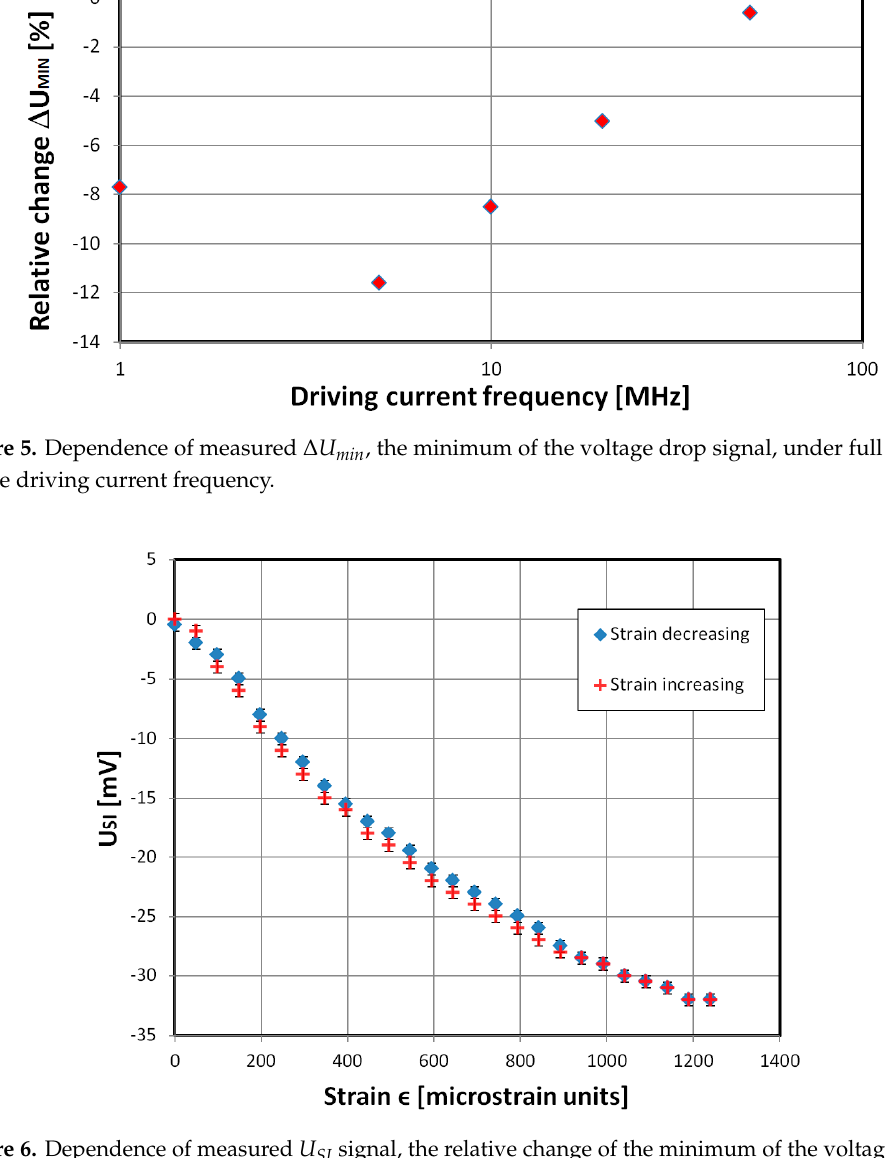
Figure 6. Dependence of measured U SI signal, the relative change of the minimum of the voltage drop signal (corresponding to the amber arrow in Figure 4), on the sample strain, for increasing (red cross) and decreasing (blue rhomb) strain values. A 5 MHz, 400 mV RMS driving signal was used. The highest SI ratio ∆𝑍/𝑍 = − 15%.